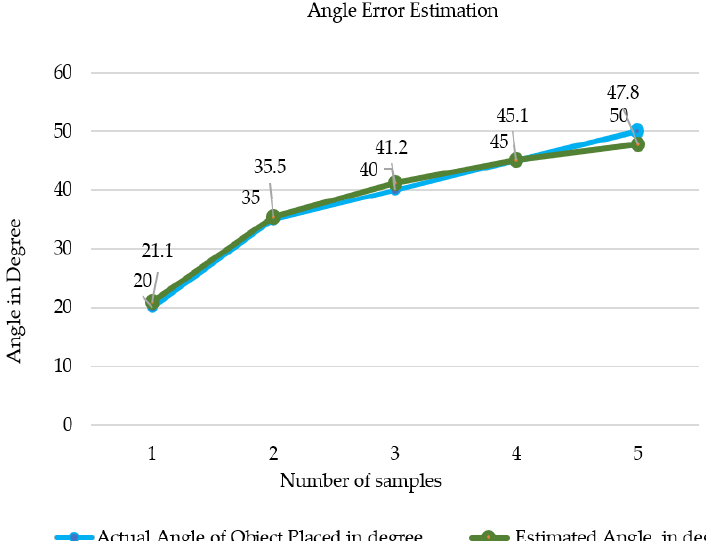
Figure 13. Represents the error of estimation and describes how the proposed method compares the actual value versus the measured value. Table 5. Error estimation of the proposed method.